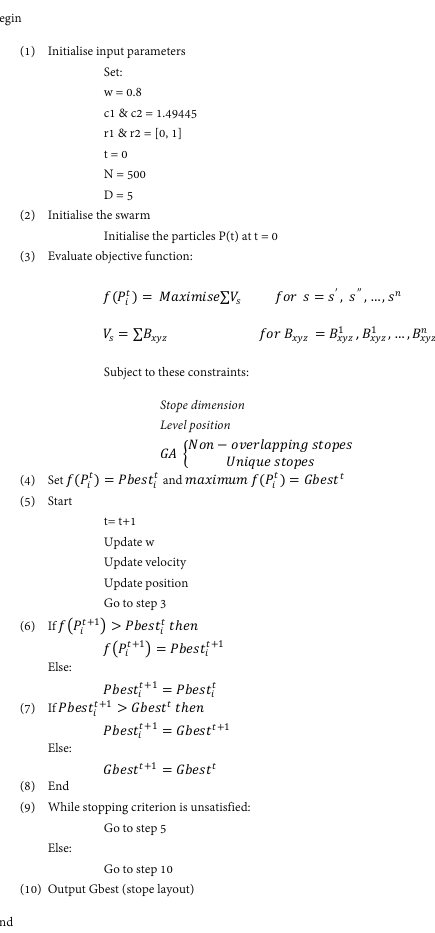
Figure 3. Pseudocode for the dual interchange algorithm. Source: [ 3].